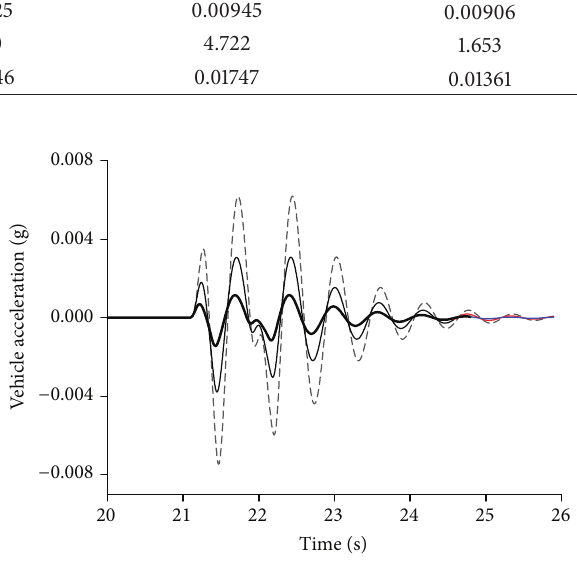
Figure 7: Vehicle acceleration corresponding to different numbers of voided elastic two-block sleepers. Bold line: one sleeper voided; solid line: two sleepers voided continuously; dashed line: three sleepers voided